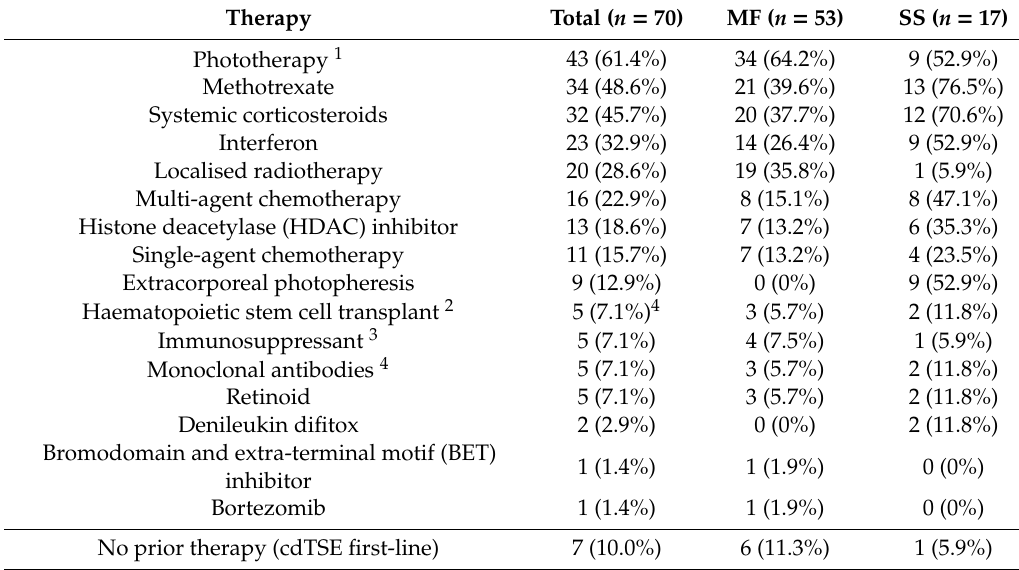
Table 2. Treatments received prior to conventional-dose total skin electron therapy (cdTSE), excluding topical